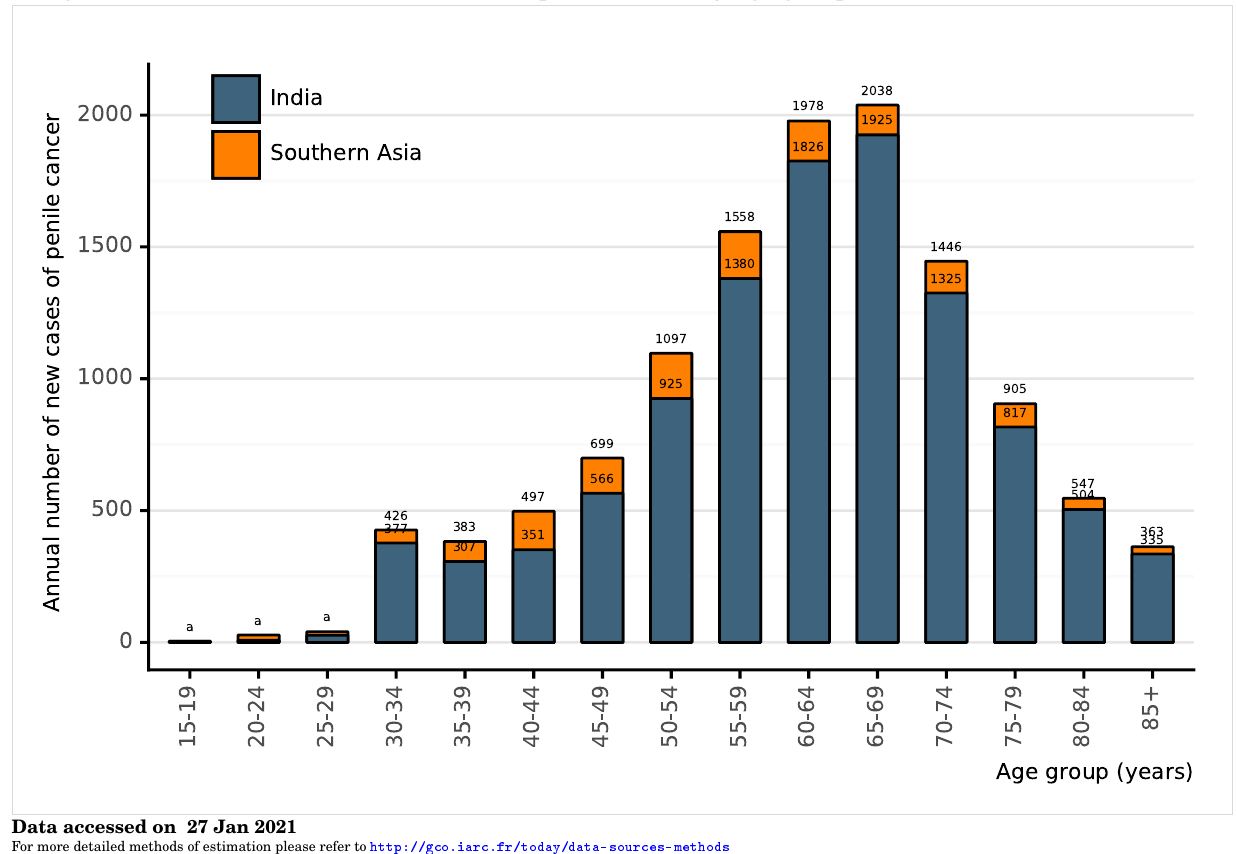
Figure 88: Annual number of new cases of penile cancer by age group in India (estimates for